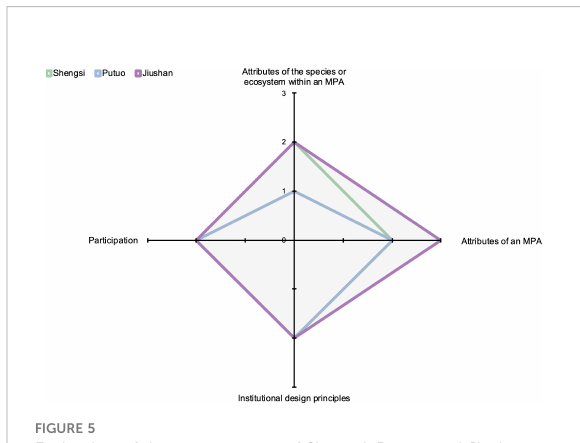
FIGURE 5 Evaluation of the management of Shengsi, Putuo, and Jiushan